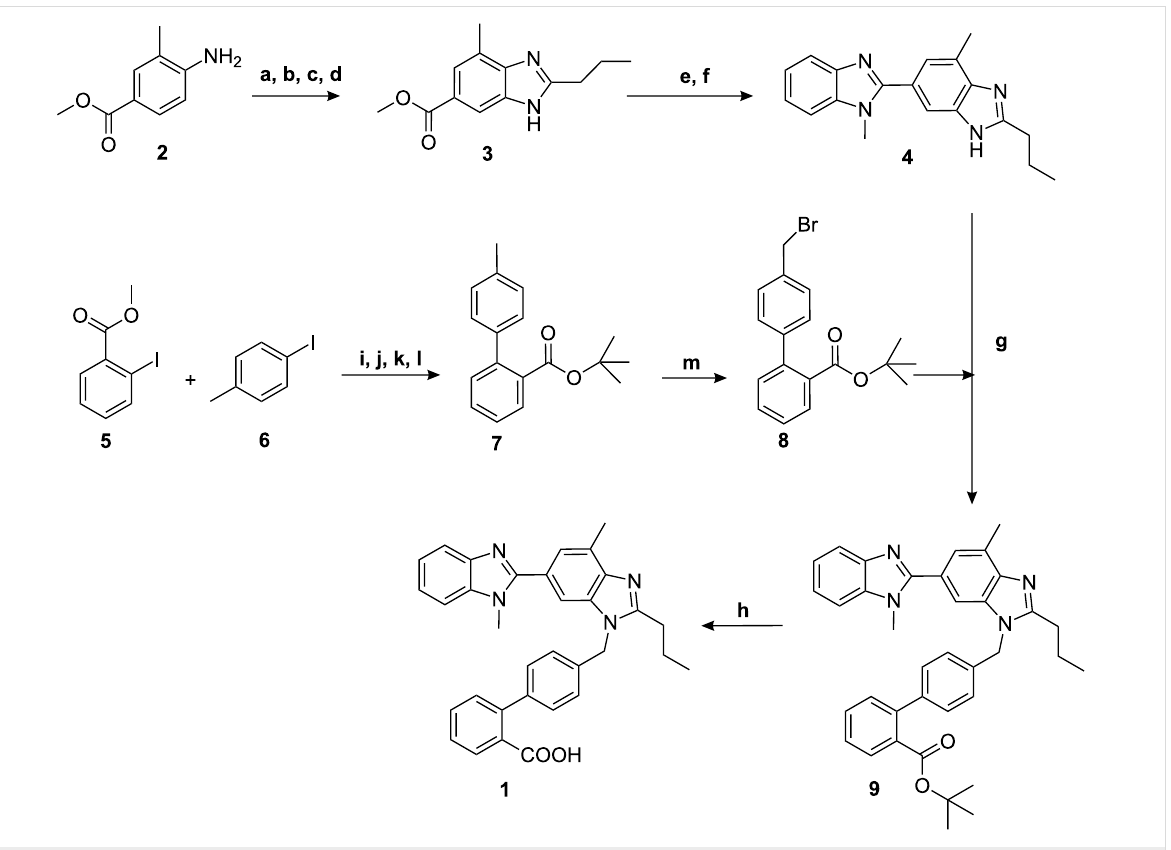
zole 4 , which is then alkylated with the 4 ′ -(bromomethyl)-2- biphenylcarboxylic acid tert -butyl ester ( 8 ) to give, after hydro- lysis of the ester group, Telmisartan ( 1 ) in 21% overall yield and with eight steps as the longest sequence